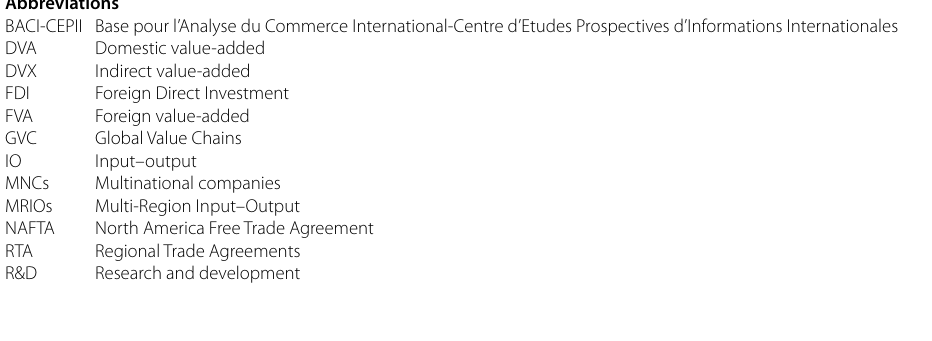
Source: Own elaboration with the EORA Country